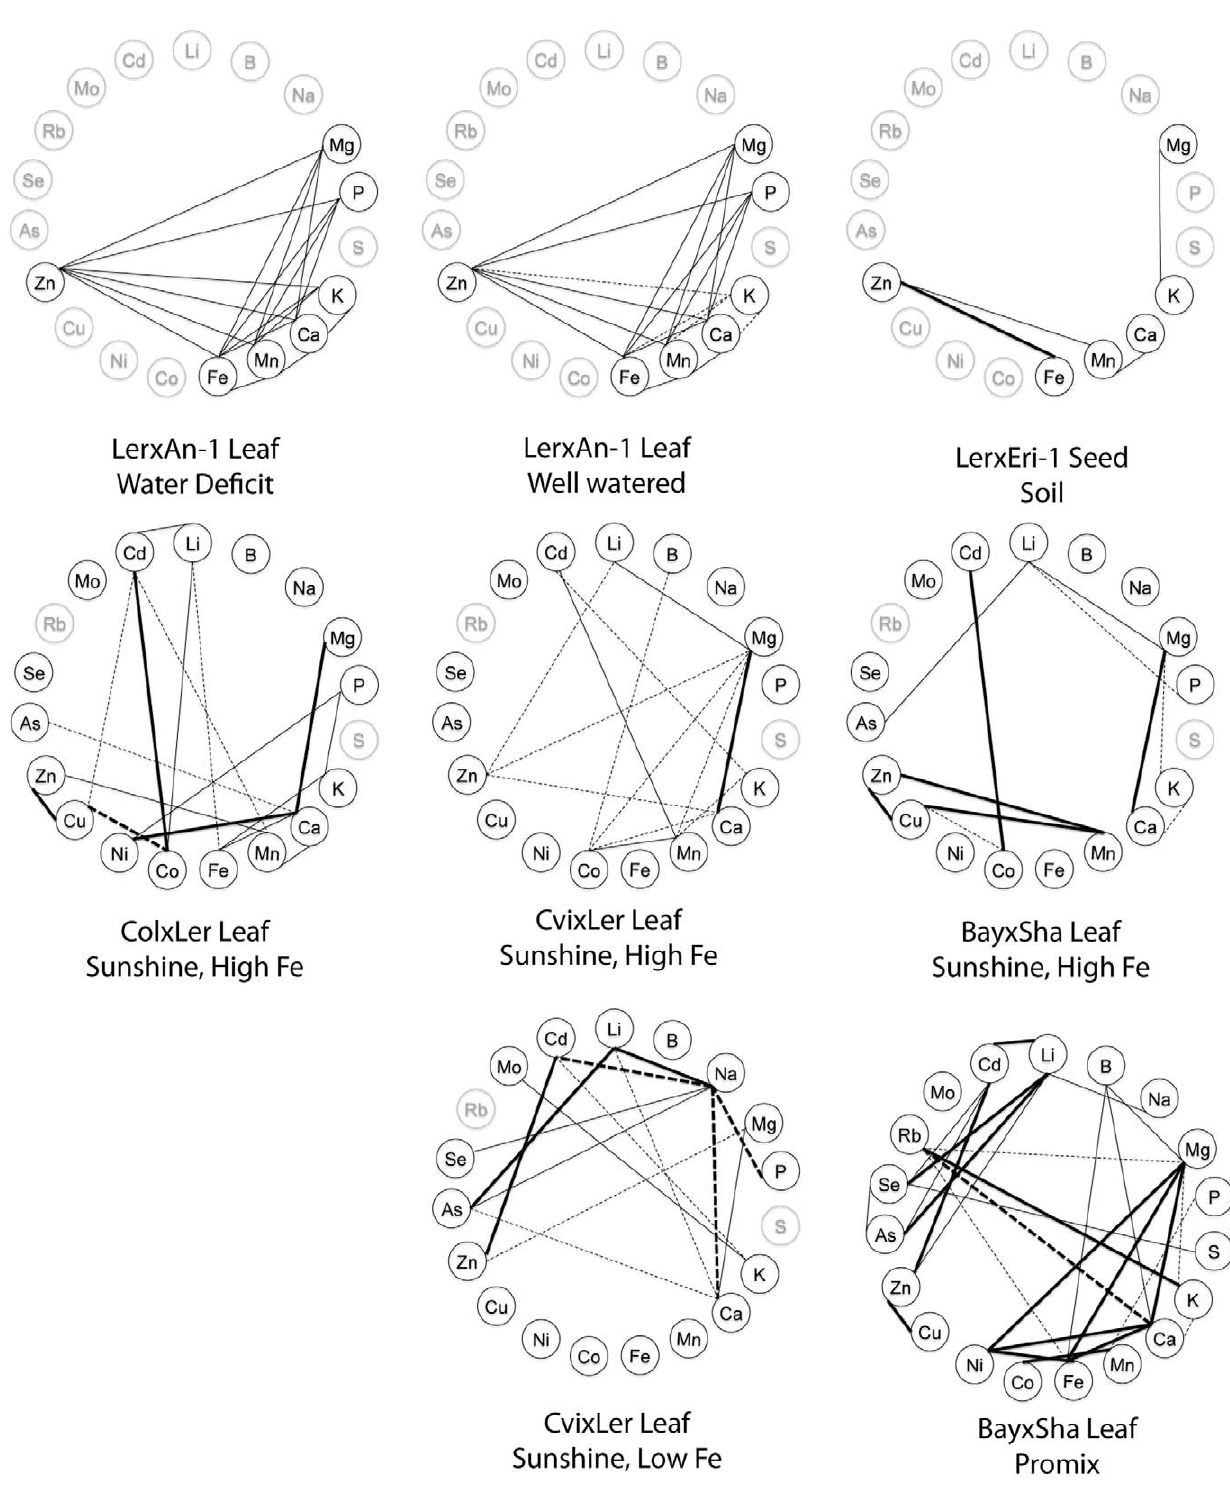
Figure 4. Correlations wheels showing significant correlations between elements within an experiment. A–B are taken from Ghandilyan 2009, [26], Figure 5. C is taken from Ghandilyan 2009, [27], Table 2. D–H taken from Buescher et al. [24] Figure 1. Only significant correlations (p , 0.001 and R 2 . 0.32) are displayed on each wheel. Positive correlations are denoted by solid lines, negative correlations are denoted by dashed lines. Thick lines indicate R 2 . 0.5, thin lines indicate 0.32 , R 2 , 0.5. Ions not measured in a given experiment are colored in grey.